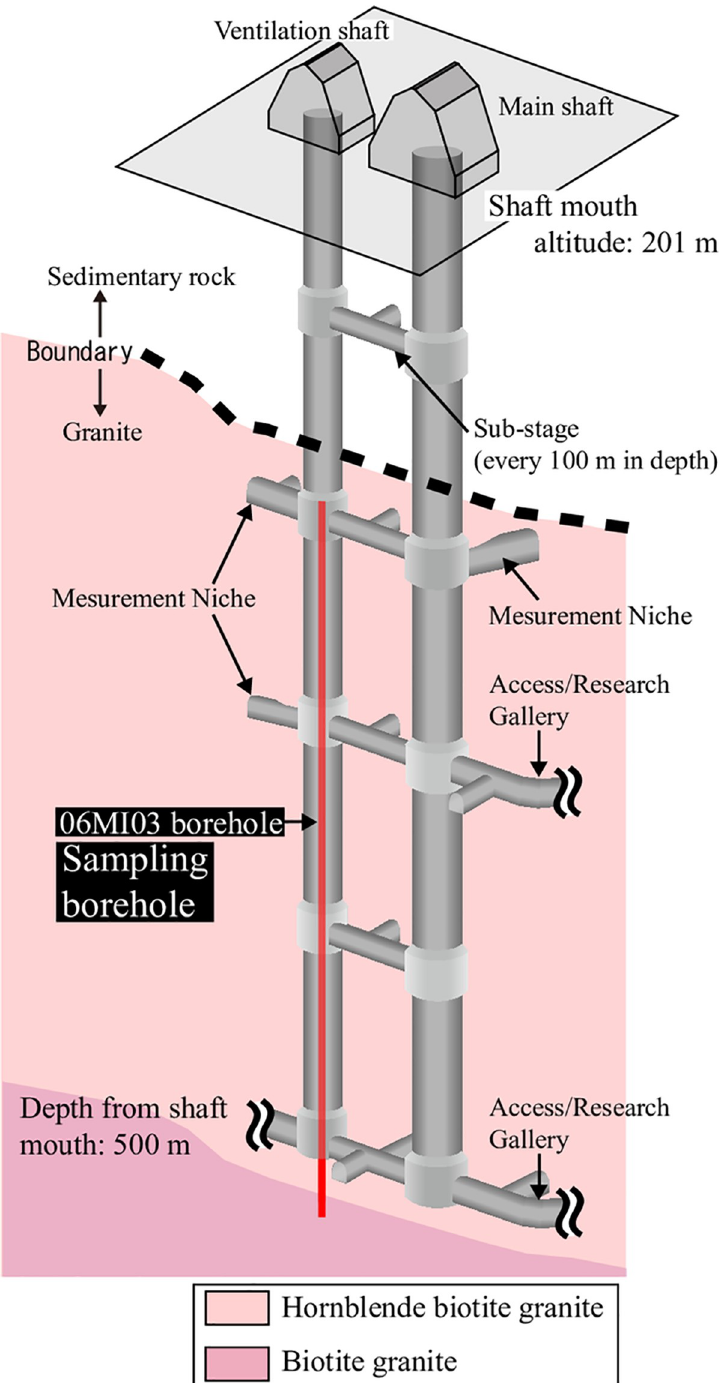
Fig 1. Mizunami Underground Research Laboratory (MURL). Schematic overview of the shafts in the MURL and borehole 06MI03, along with the distribution of hornblende-biotite granite and biotite granite in the lithofacies. Shafts at a depth of approximately 170 m intersect the unconformity between the Mizunami Group and the Toki granite.